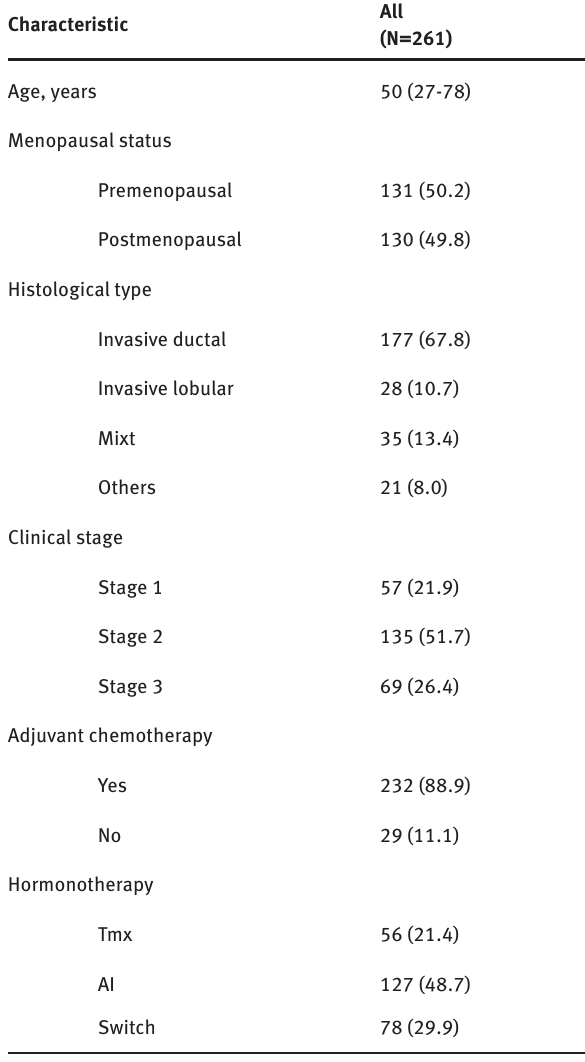
Table 1: Baseline characteristics of the patients